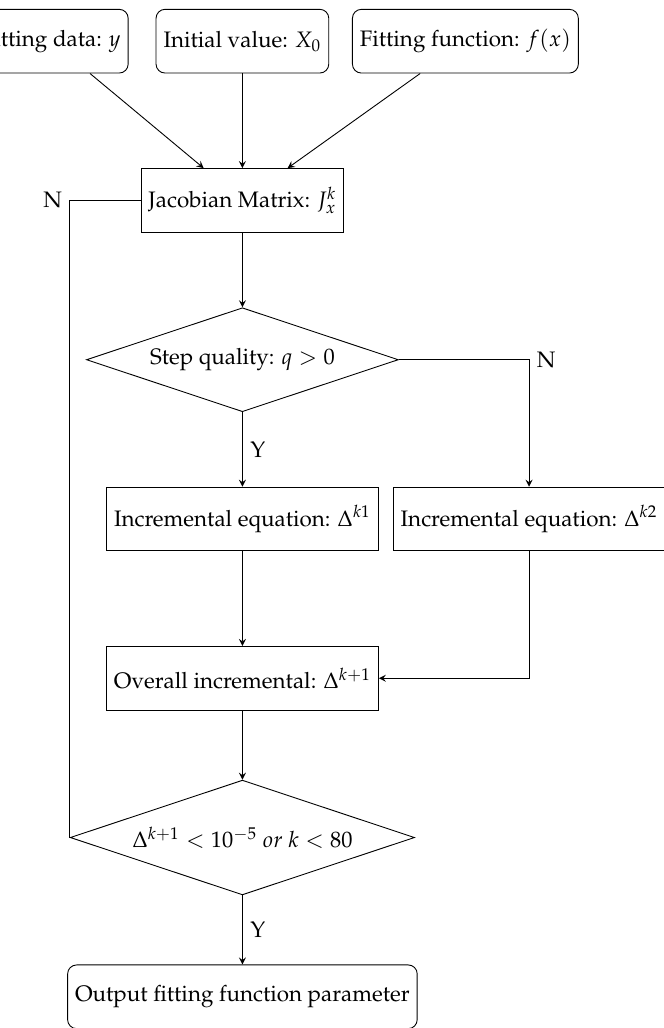
Figure A1. Flowchart of the Levenberg–Marquardt Parallel Method.